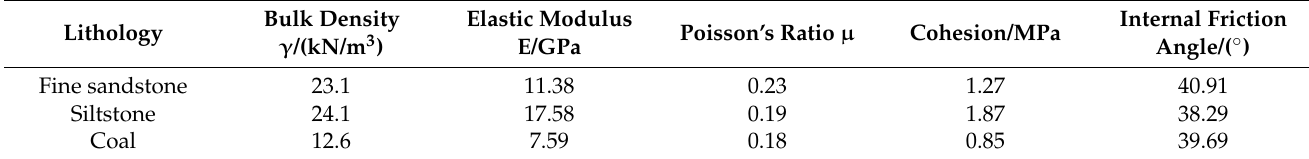
Figure 4. Numerical calculation model. Table 2. Physical and mechanical parameters of each rock